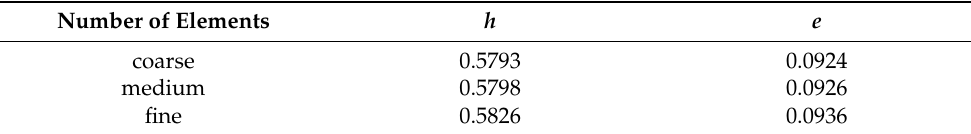
Table 1. The results with different numbers of elements.